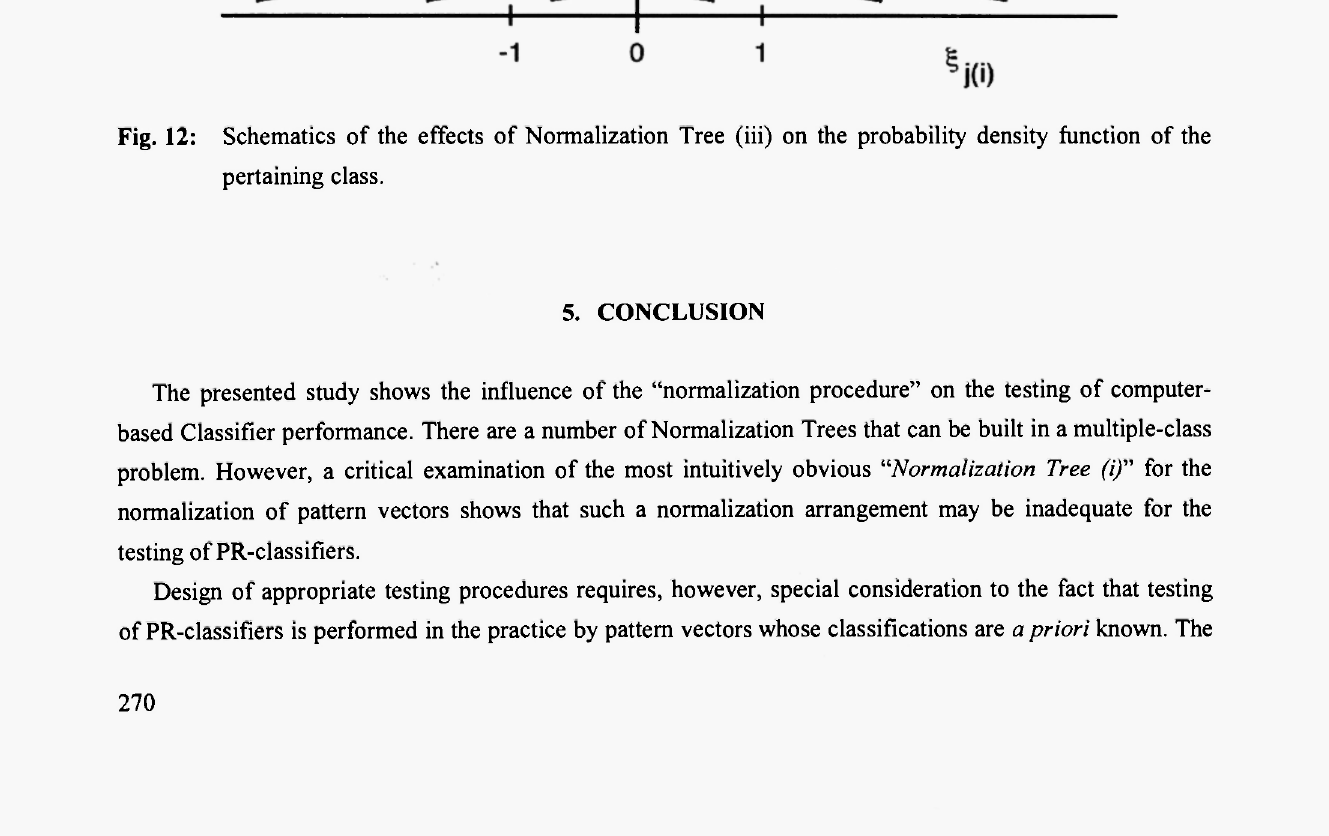
Fig. 12: Schematics of the effects of Normalization Tree (iii) on the probability density function of the pertaining